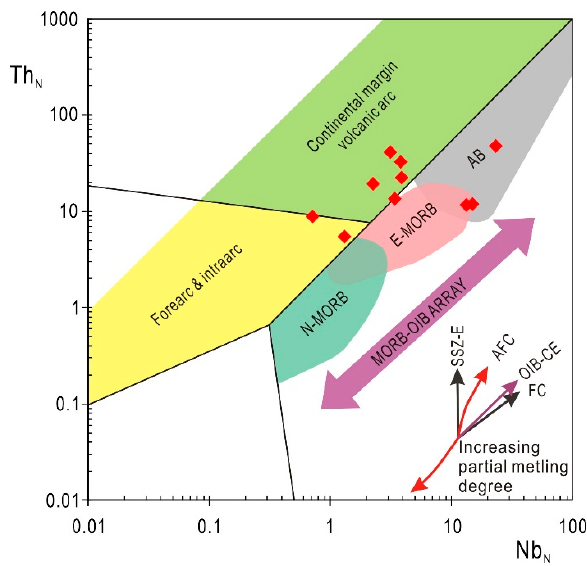
Figure 11. Th N vs. Nb N plot for the Haoyaoerhudong gabbro (after [66]). The N-MORB composition is from [42].